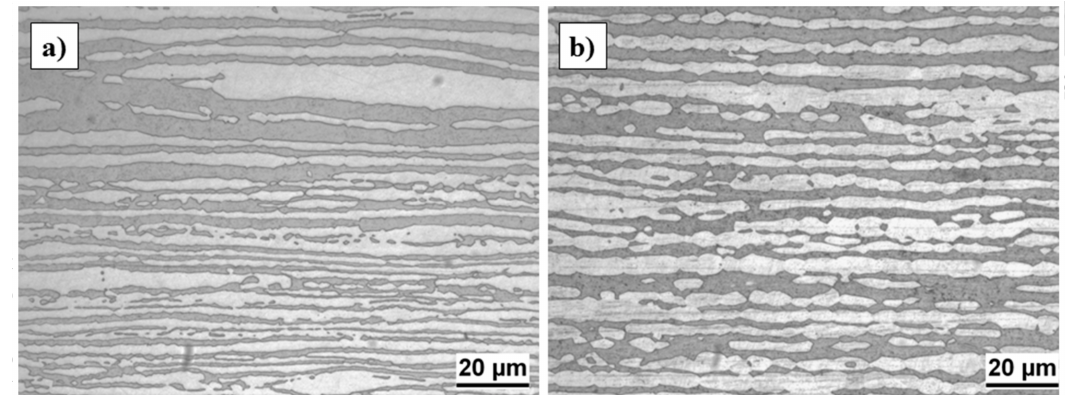
Figure 1. Microstructure of the long transversal section (parallel to load direction in slow strain-rate tests (SSRT)) of DSS 2304 ( a ) and LDSS 2404 ( b ), after etching with Beraha’s